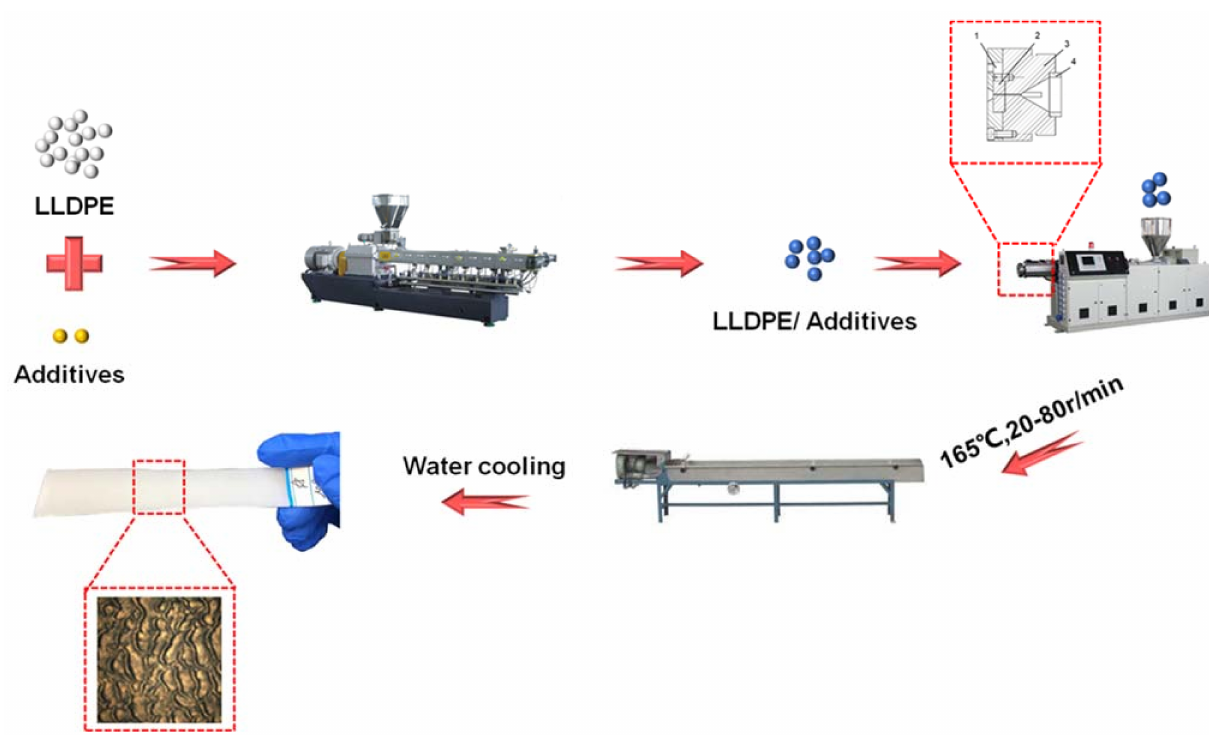
Figure 2. Preparation process of shark skin structured hydrophobic